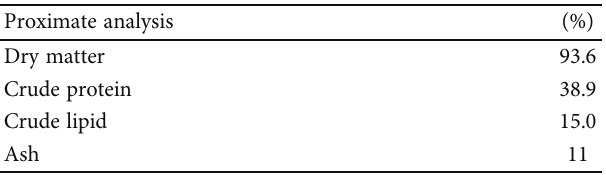
Table 1: Chemical composition of the feed used as basal diet during the